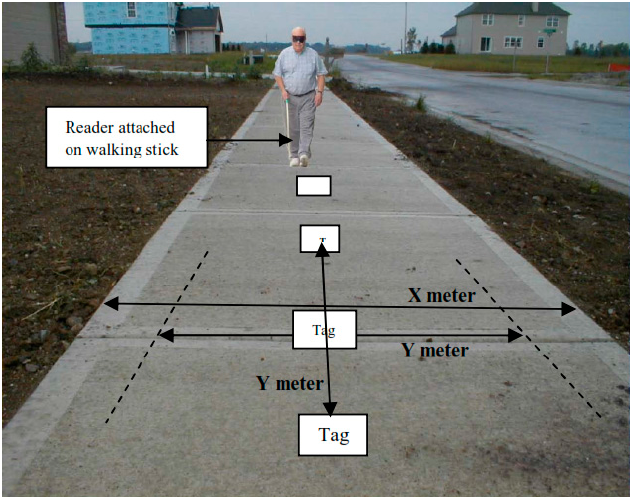
Figure 13. Distance of the frequency detection on sidewalk [32].